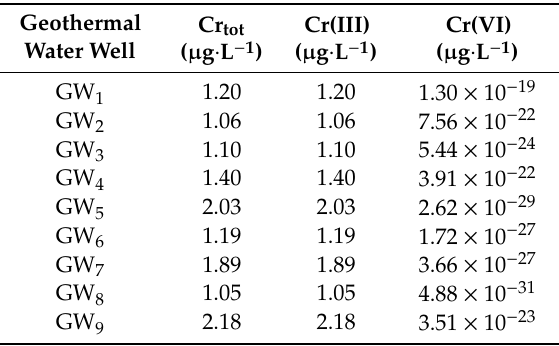
Table 3. Results of chromium speciation